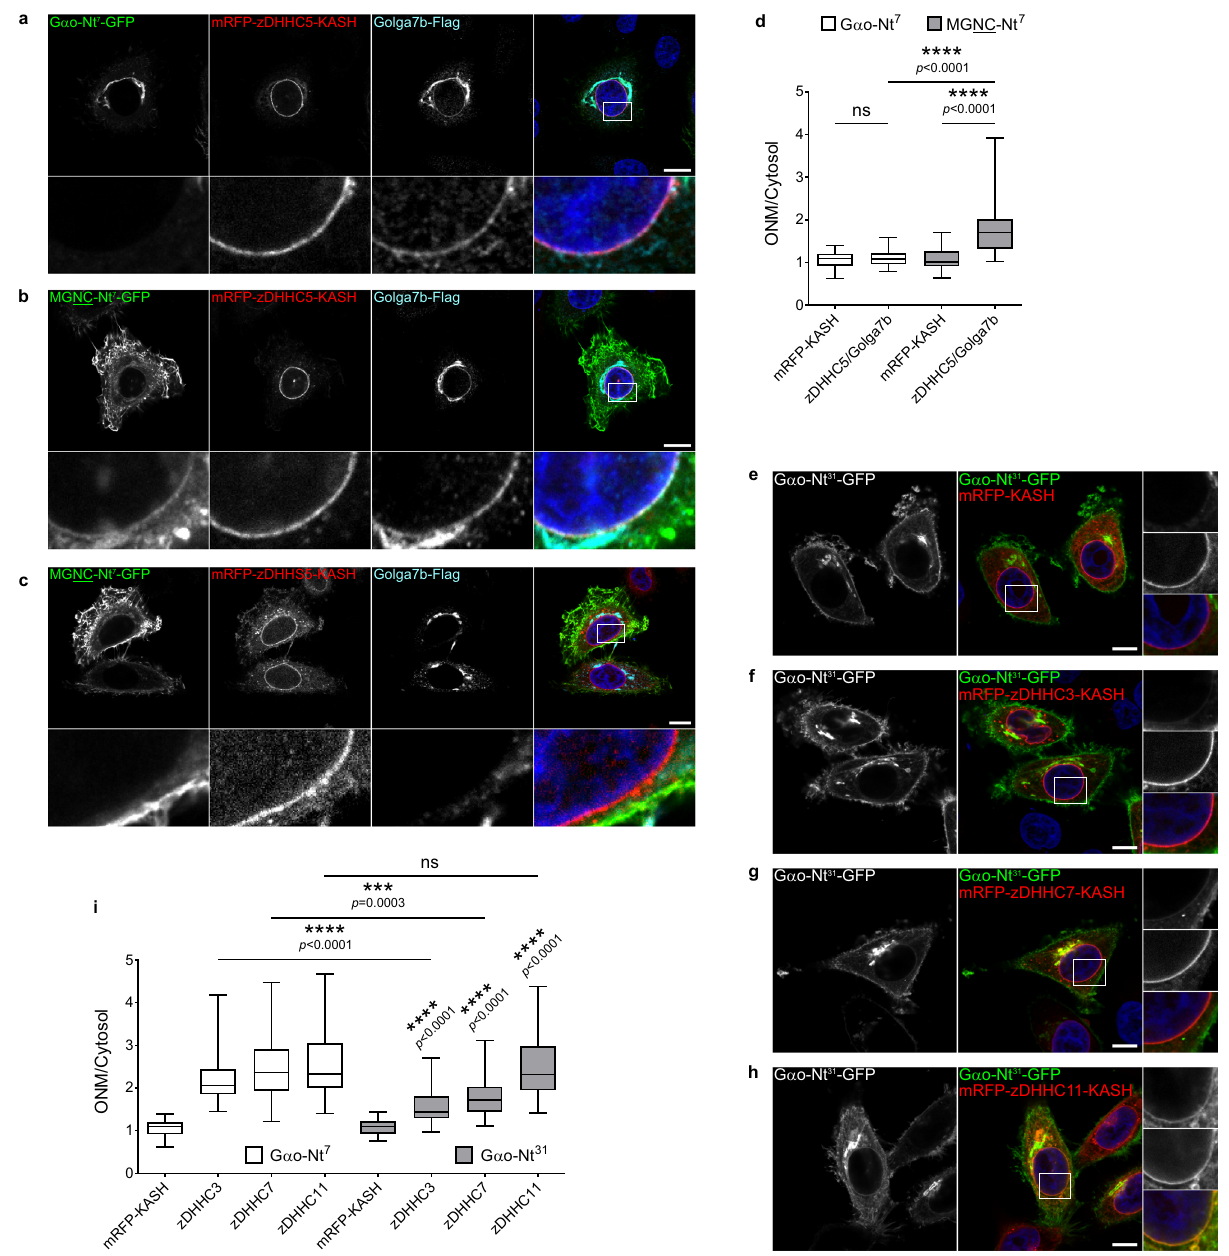
Fig. 6 The zDHHC5-Golga7b complex. a – d The SwissKASH assay for G α o-Nt 7 -GFP ( a ) and MGNC-Nt 7 -GFP ( b ) using mRFP-zDHHC5-KASH and Golga7b-Flag in HeLa cells. Note that the KASH-fusion of zDHHC5 induces the ONM recruitment of MGNC-Nt 7 -GFP ( b ) and Golga7b ( a , b ), but not of G α o-Nt 7 -GFP ( a ). ONM localization of MGNTC-Nt 7 -GFP and Golga7b is not induced by the inactive DHHS-mutant of zDHHC5 (zDHHS5; c ). Cells were immunostained against Flag-tag and nuclei were stained in blue with DAPI. Marked regions are magni fi ed at the bottom panels. Underlined letters indicate residues substituted in G α o-Nt 7 . Mean fl uorescence intensity ratios of GFP-fusions at the ONM versus cytosol ( d ). Box plots indicate median (middle line), 25th, 75th percentile (box), and lowest, highest value (whiskers); three independent experiments (G α o-Nt 7 and mRFP-KASH, n = 44; G α o-Nt 7 and zDHHC5-Golga7b, n = 49; MGNTC-Nt 7 and mRFP-KASH, n = 49; MGNTC-Nt 7 and zDHHC5-Golga7b, n = 48). e – i The SwissKASH assay for G α o-Nt 31 - GFP using the control mRFP-KASH ( e ), zDHHC3 ( f ), zDHHC7 ( g ), and zDHHC11 ( h ). Color-channels are listed vertically top-to-bottom and selected areas are magni fi ed to the right with the channels displayed also vertically in the same order. Mean fl uorescence intensity ratio (ONM versus cytosol) of G α o-Nt 31 -GFP compared to G α o-Nt 7 -GFP ( i ). Box plots indicate median (middle line), 25th, 75th percentile (box), and lowest, highest value (whiskers); three independent experiments (For G α o-Nt 7 : mRFP-KASH, n = 44; zDHHC3, n = 50; zDHHC7, n = 46; zDHHC11, n = 47. For G α o-Nt 31 : mRFP-KASH, n = 42; zDHHC3, n = 45; zDHHC7, n = 40; zDHHC11, n = 46). a – c , e – h Scale bars, 10 µ m. P values were determined using one-way ANOVA Š ídák test for ( d , i ). ns: not signi fi cant. Source data are provided as a Source Data fi